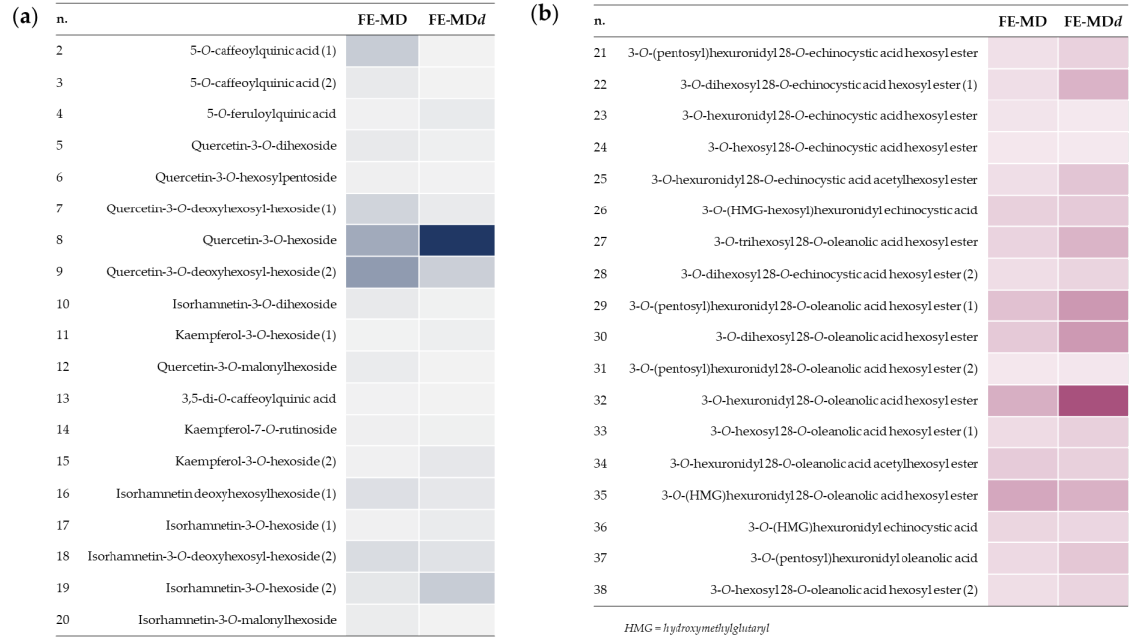
Figure 5. Heatmaps of polyphenols ( a ) and triterpene saponins ( b ) in floret encapsulates before and after in vitro digestion (FE-MD and FE-MDd, respectively).